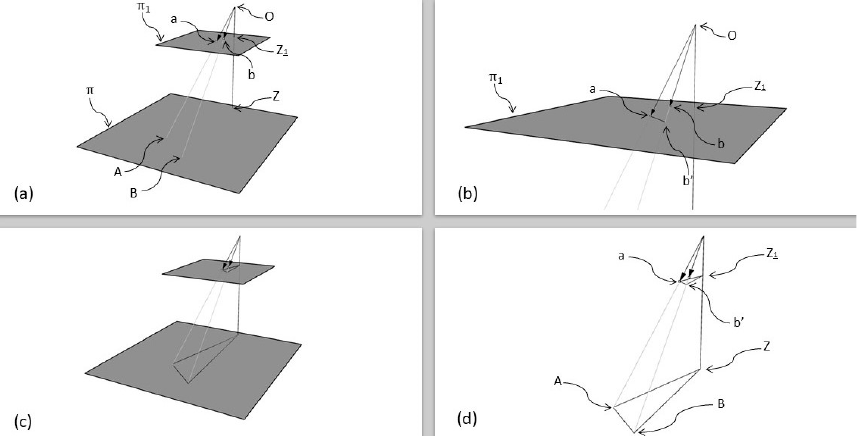
Figure 5. The horizontal plane π 1 is introduced in the model described in Figure 4. In this graphical representation, the image plane is not shown ( a ). Focus on the plane π 1 ( b ). Whole model ( c ) and visualization of the homologous triangles A-B-Z and a-b-Z 1 ( d ). (Source: personal collection). The point Z1 has coordinates equal to (0, 0, z π 1 ) but z π 1 is equal to z a , since the Z 1 and the point a are lying on the same horizontal plane π (cid:2869) . Therefore, the parametric equation of the plane π (cid:2869) is given as follows: